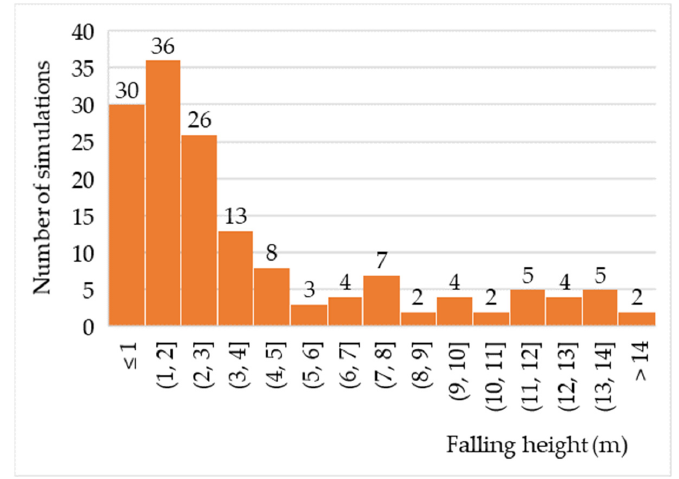
Figure 13. Number of simulations at different heights of simulated precipitation [32]. Note: data whose values are given in ranges are not included in the analysis.